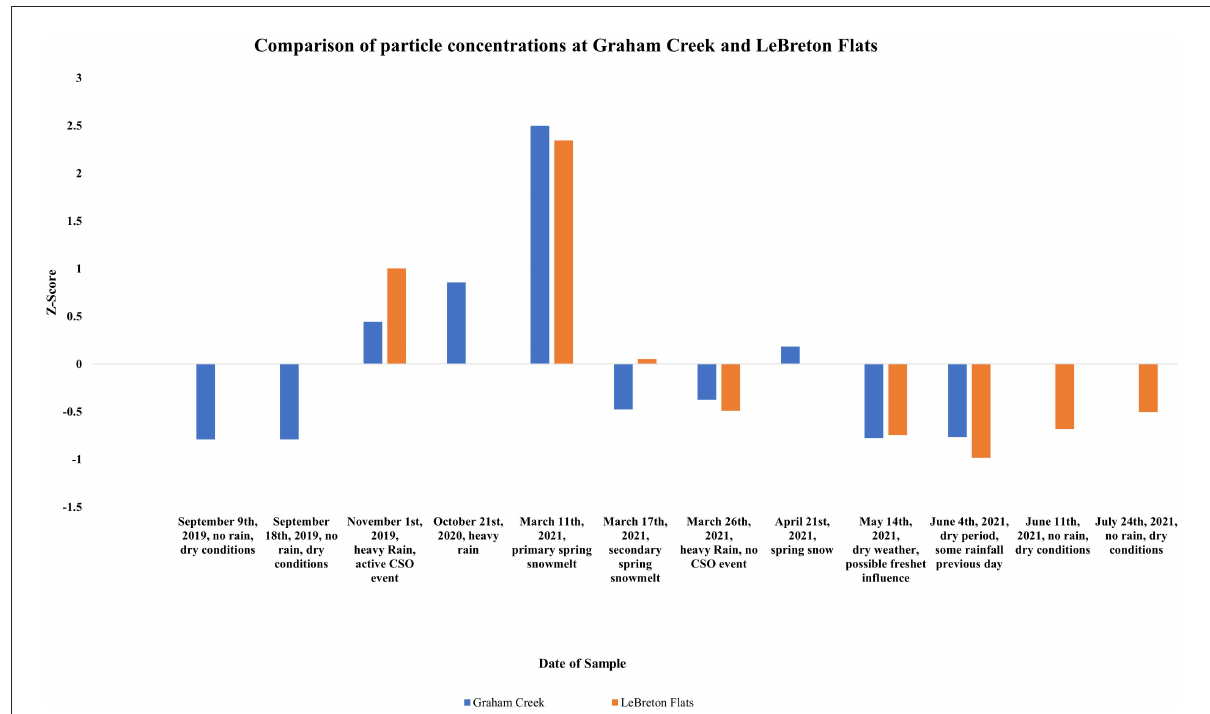
FIGURE2 Z-score values for comparison of particle concentration between Graham Creek and LeBreton Flats during various temporal events.